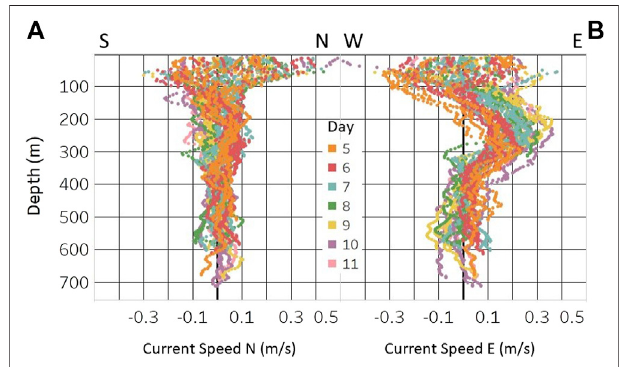
FIGURE 10 | Average current data for all dives showing how the north (A) and east (B) velocity components vary with depth (vertical axis). The data are color-coded by the date of the dive (November 2018).